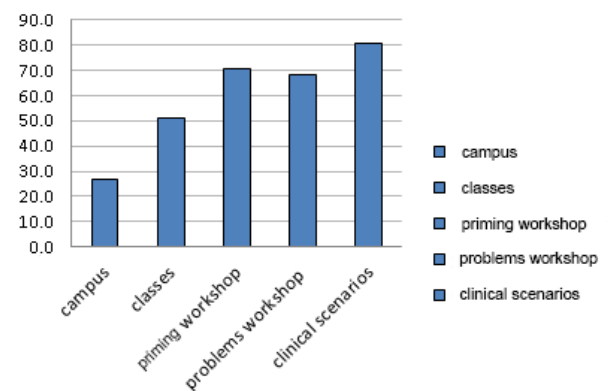
Fig. 4 - Course components usefulness assessment (%). The most valued components were clinical cases and priming